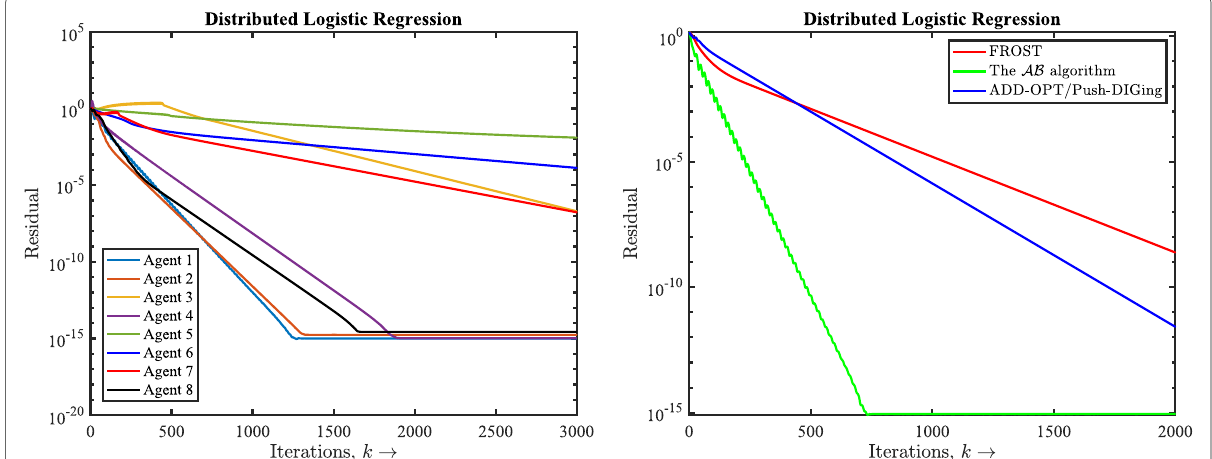
Fig. 2 (Left) Each curve represents the linear convergence of FROST when the corresponding agent uses a positive step-size, optimized manually, while every other agent uses zero step-size. (Right) Convergence comparison across different